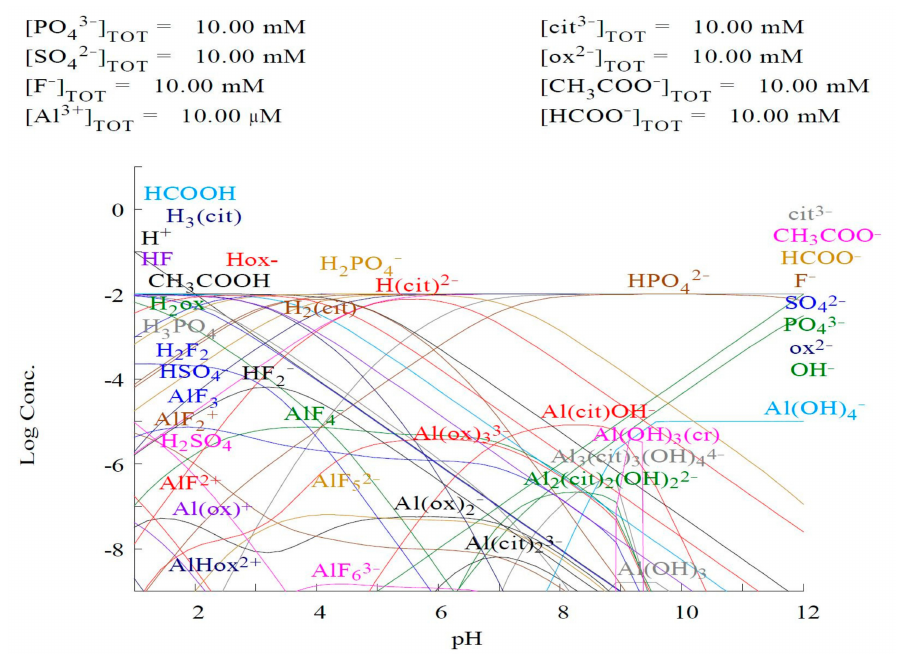
Figure 9. Simple modeling system for constant Al and ligand concentration in function of